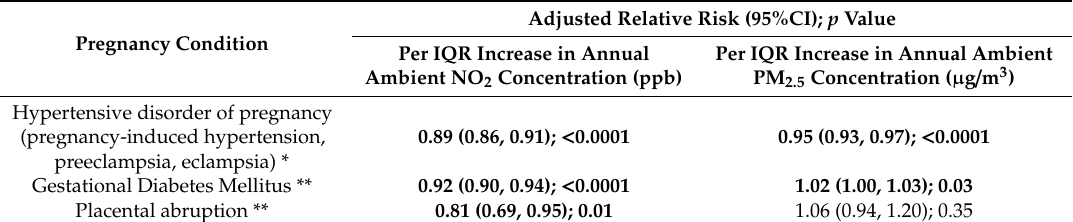
Table 2. Association between average ambient NO 2 and PM 2.5 exposure in pregnancy and selected pregnancy conditions for births in Victoria, Australia between 1 March 2012 and 31 Dec 2015. Pregnancy